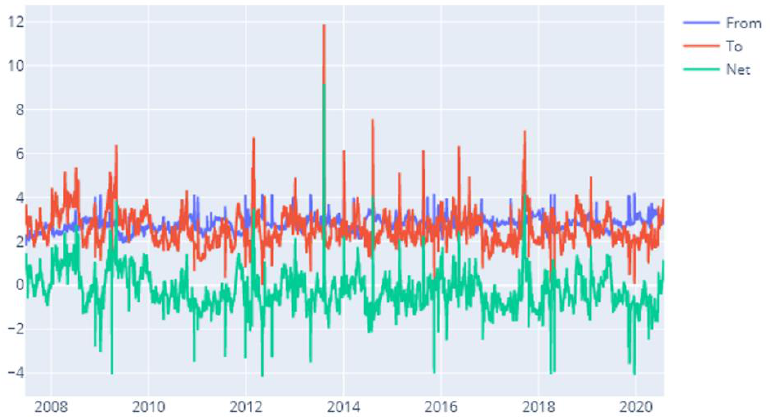
Figure 5. Entropy spillovers — Delta CoVaR.